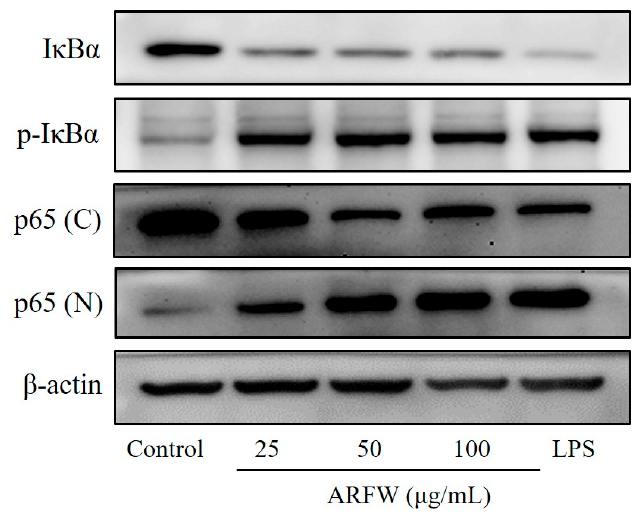
Figure 4. Effect of ARFW on NF-kB activity in RAW264.7 cells. Cells were treated with ARFW or LPS (100 ng/mL) for 15 min. Total cellular proteins were prepared and subjected to western blot analysis for determination of I κ B α and p -I κ B α protein levels. Nuclear (N) and cytosolic (C) proteins were isolated, and the levels of p65 were determined by Western blot analysis.